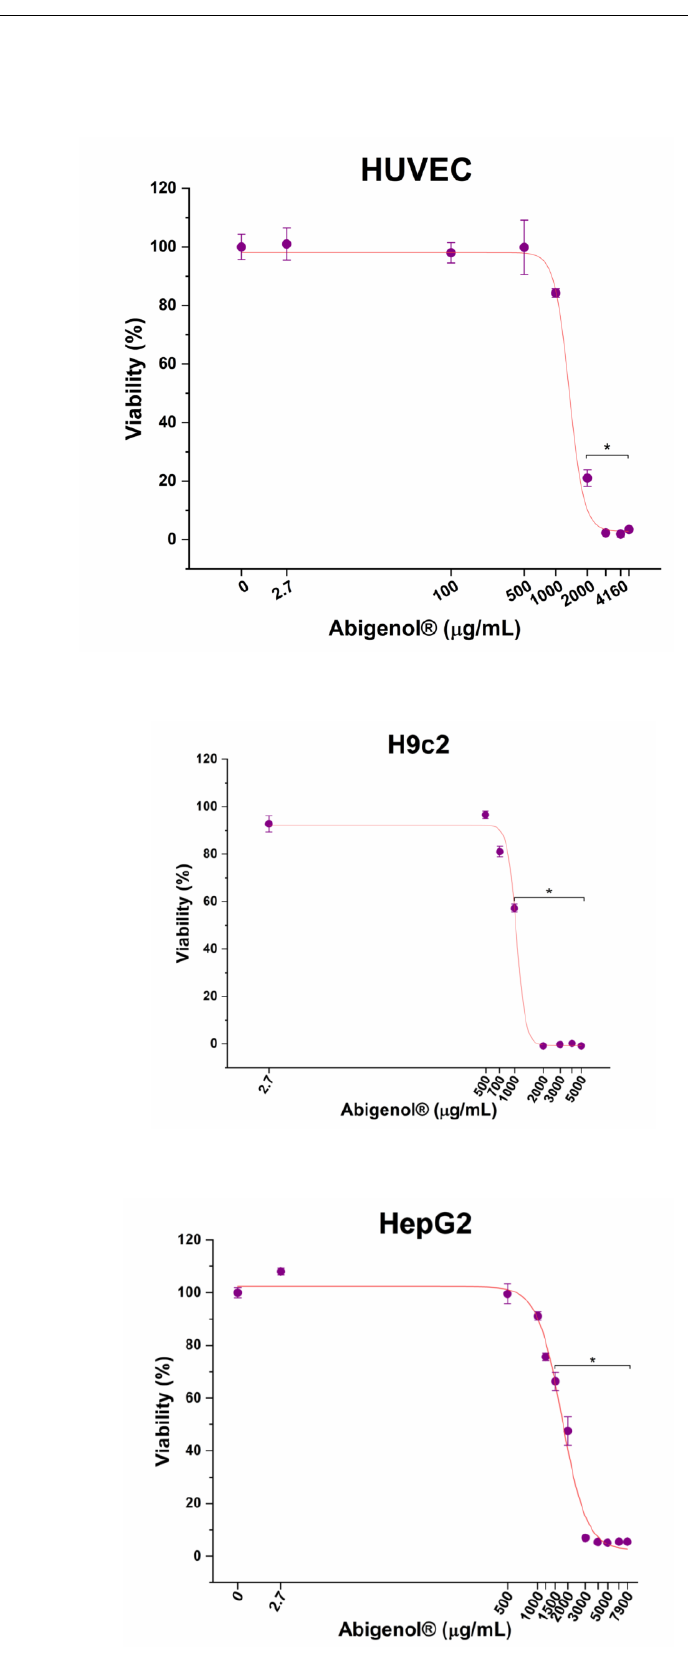
Figure 6. Impact of increasing concentrations of Abigenol ® /AlbiPhenol ® on in vitro HUVEC cells ( A ), H9c2 cells ( B ) and HepG2 cells ( C ). * p < 0.05 (n =